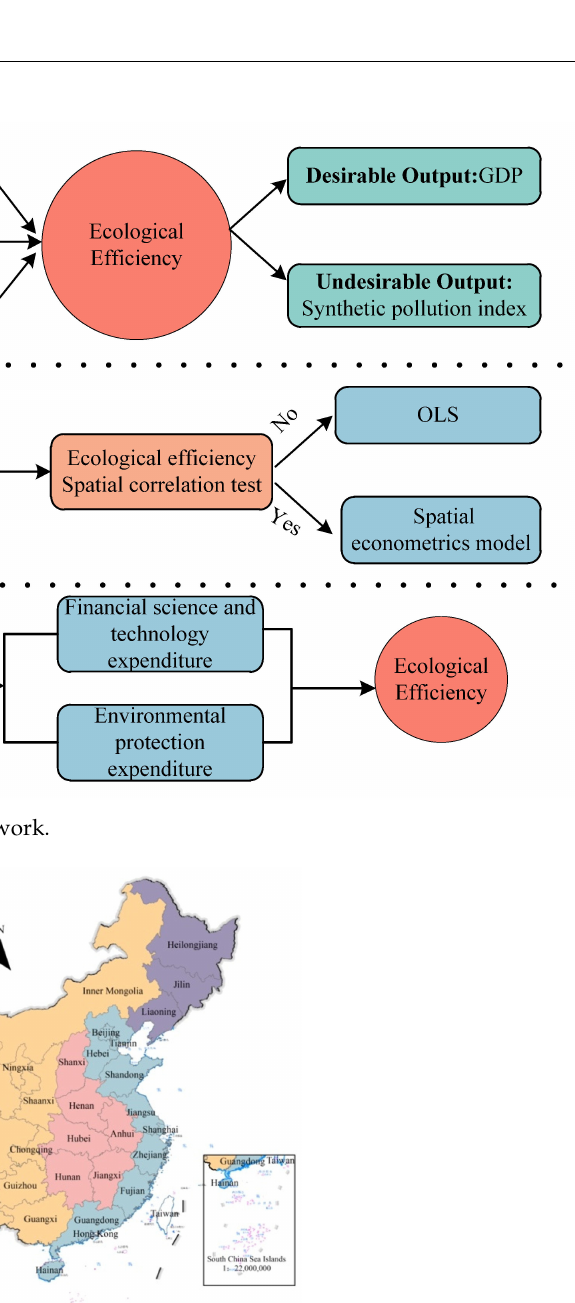
Figure 2. Division of four regions in China. Note: the map is drawn according to the standard map service website of the Ministry of Natural Resources (map review no. GS (2020)